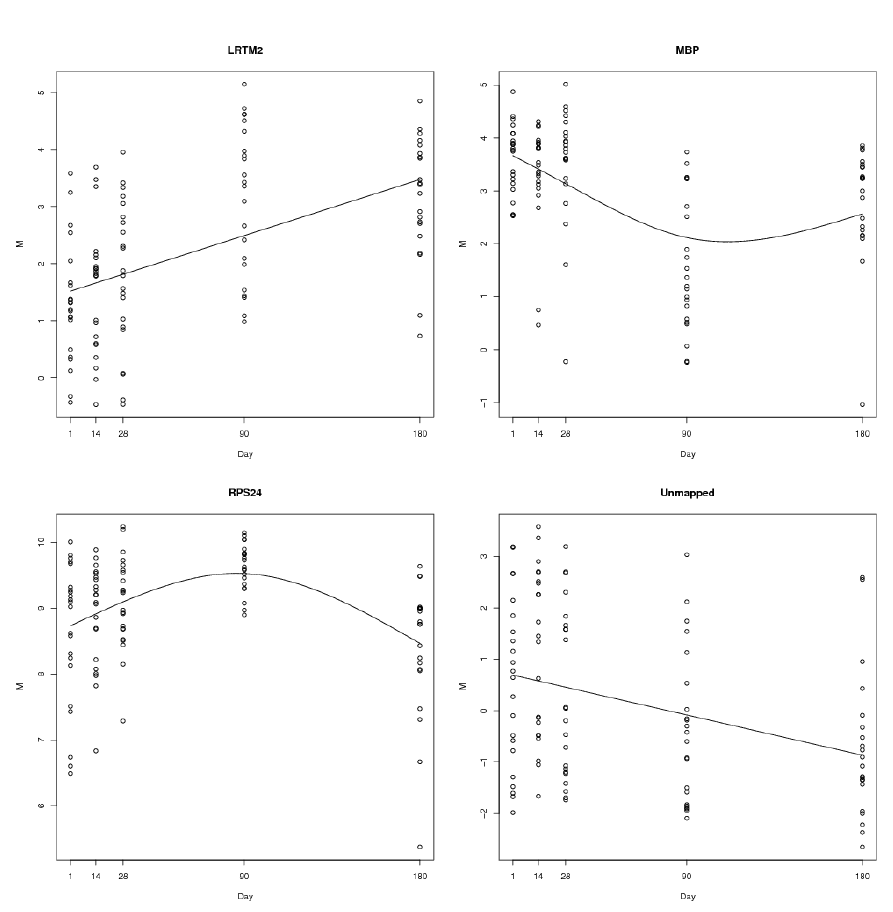
Figure 5 – Outlying genes in the fPCA loadings plot shown in Figure 4. These are some of the genes which show the greatest change in expression levels over